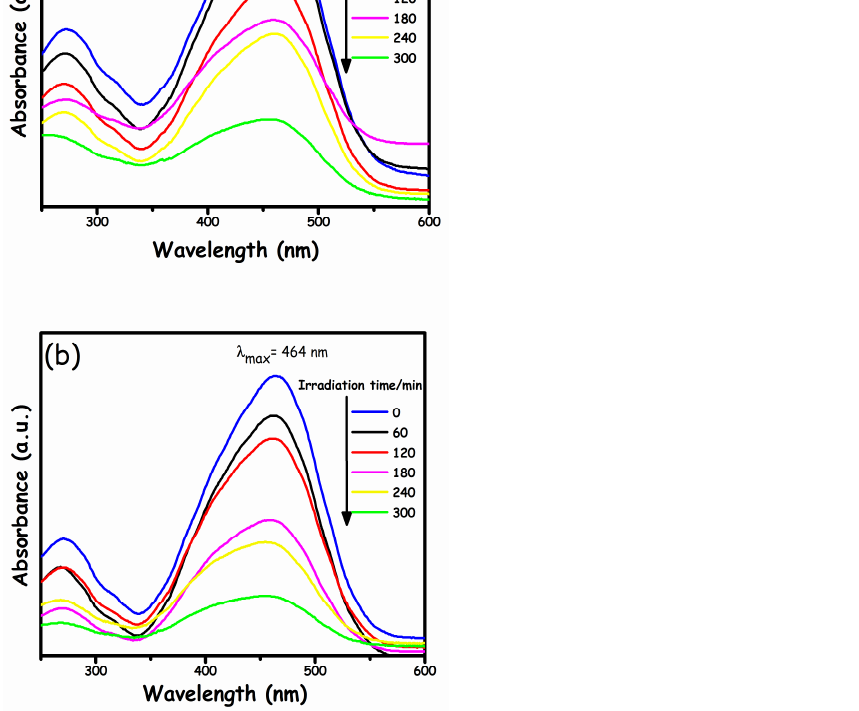
Figure 6. UV-vis absorption spectral changes of MO with time in ( a ) pure g-C 3 N 4 and ( b ) g-C 3 N 4 /α Fe 2 O 3 nanocomposite under light illumination.